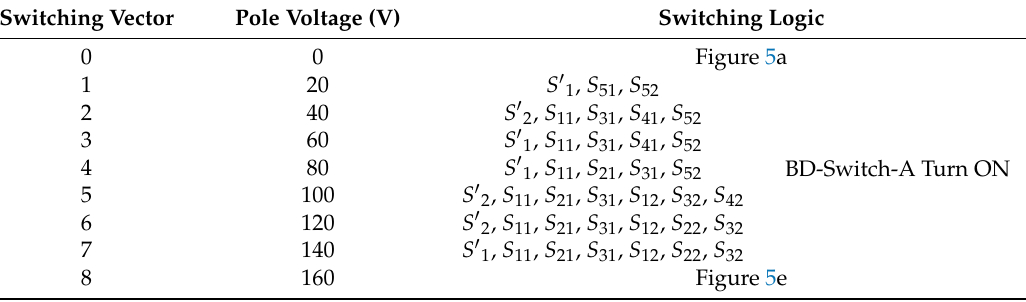
Table A5. Switching logic in the cascaded stage and PG-stage for generating 9 levels in the pole voltage, V Ag . Switching